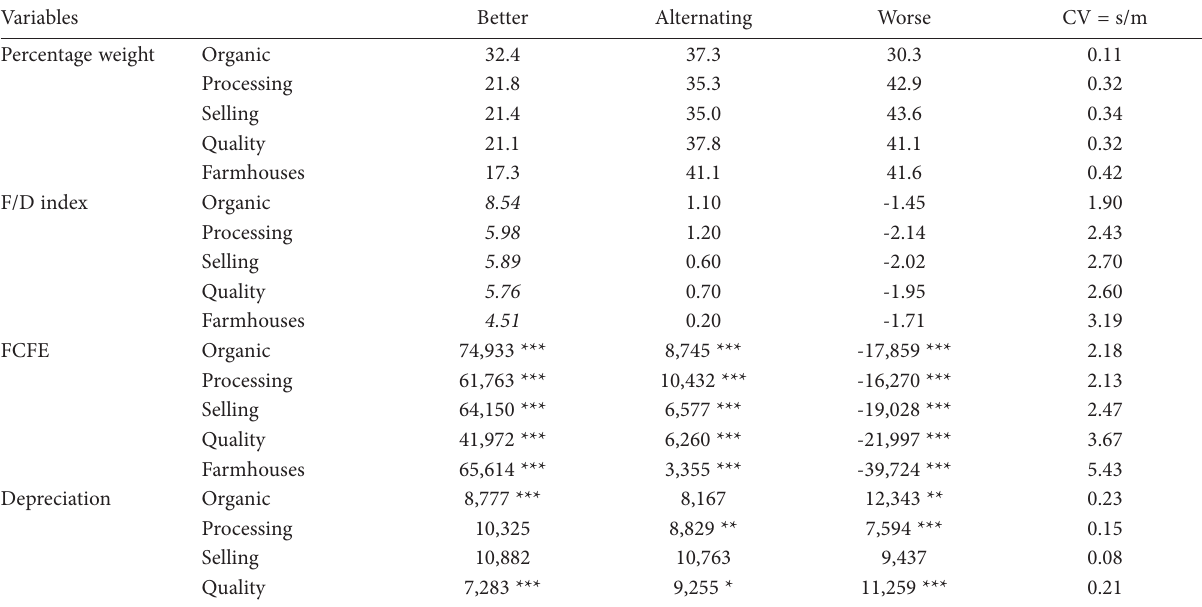
Table 5. farms with better , alternating, or worse results – percentage, F/D index, FCFE and Depreciation, coefficient variation (CV). Statisti- cal significance of differences among the various groups